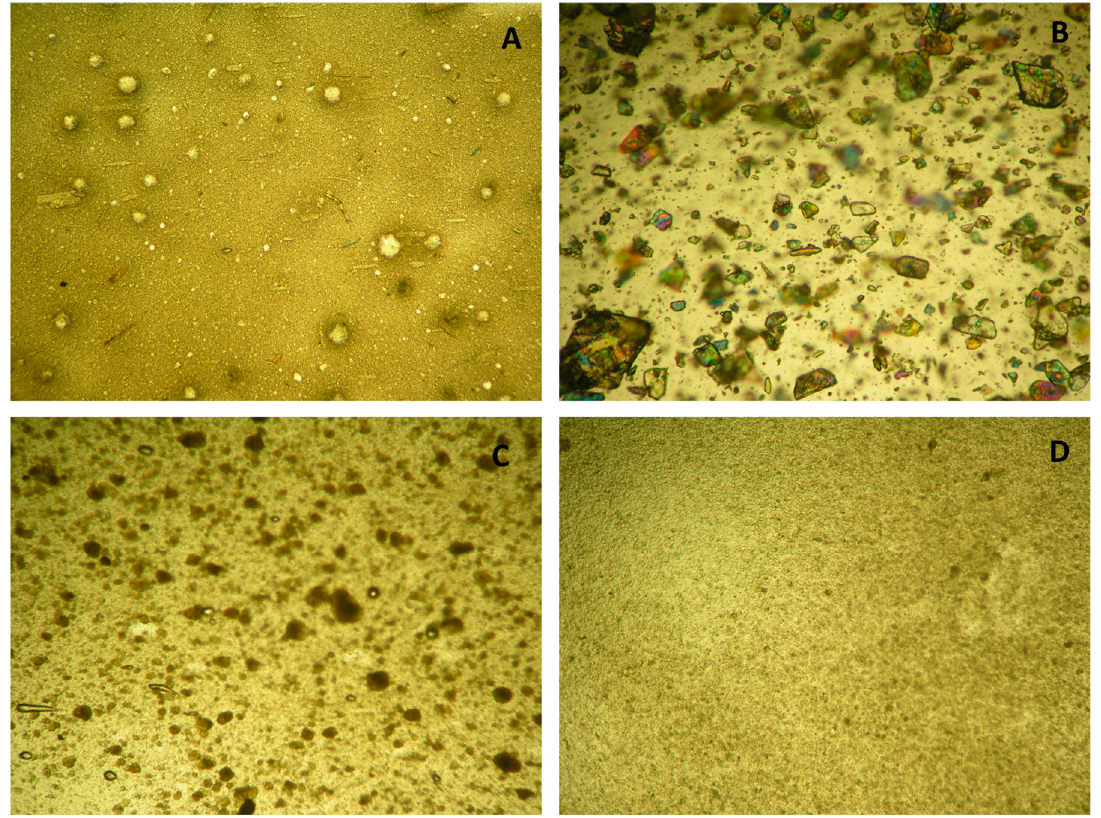
Figure 5. Pictures obtained using an optical microscope: ( A ) Tiobec ® ; ( B ) ALA-H; ( C ) MgAl-ALA-H, and ( D ) ZnAl-ALA.